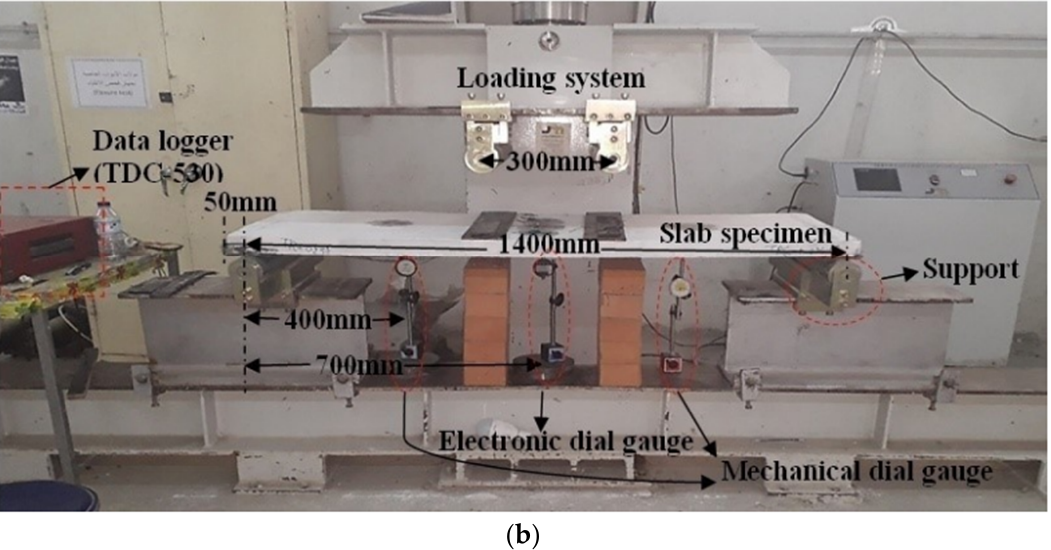
Figure 5. Four-point bending test set-up. ( a ) Schematic diagram of the testing machine. ( b ) Four-point bending test in laboratory.